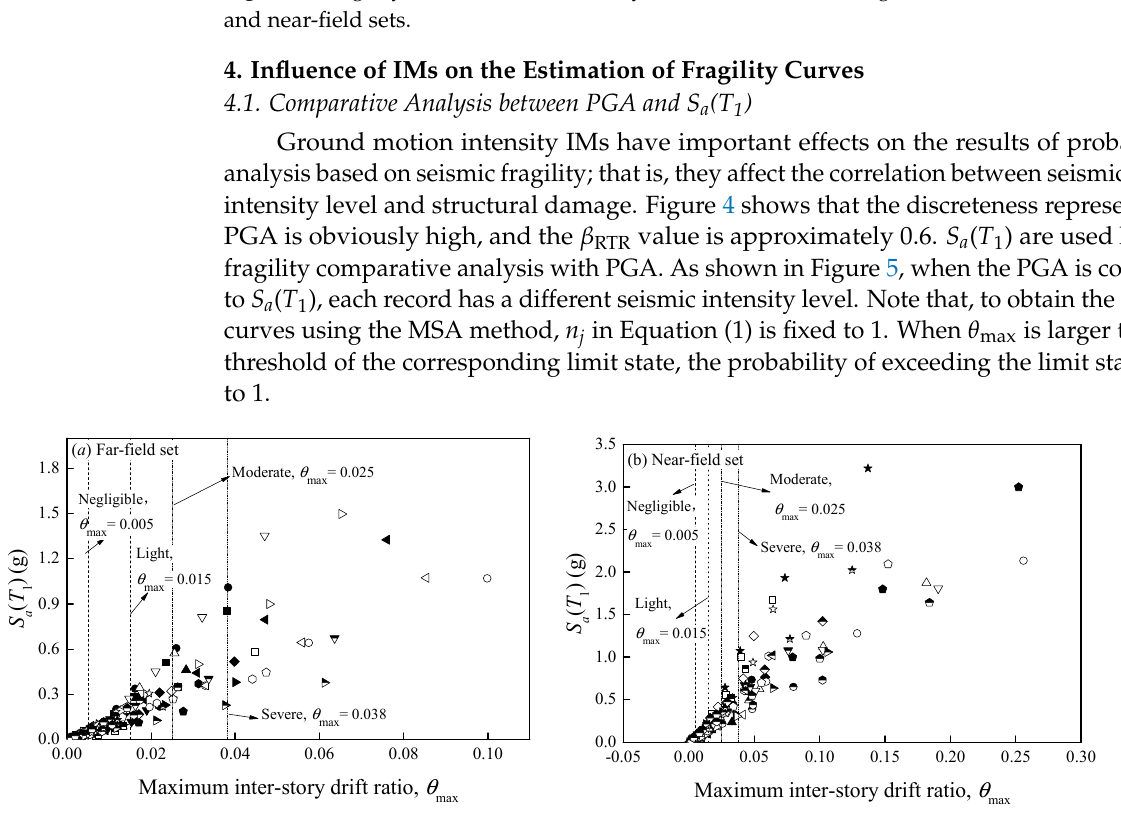
Figure 4. Fragility curves characterized by PGA for the four damage limit states in cases of far-field and near-field sets.